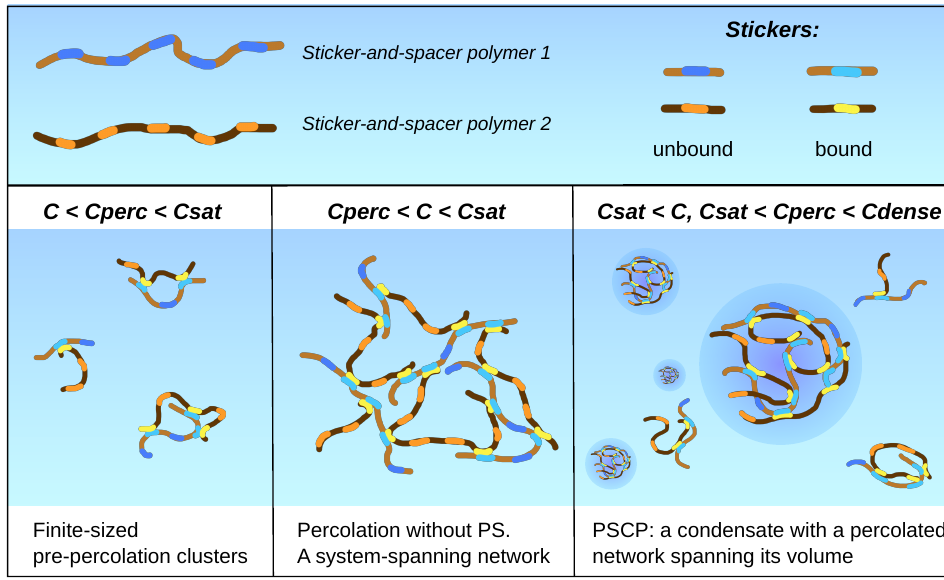
Figure 1. The relation between phase separation (PS) and